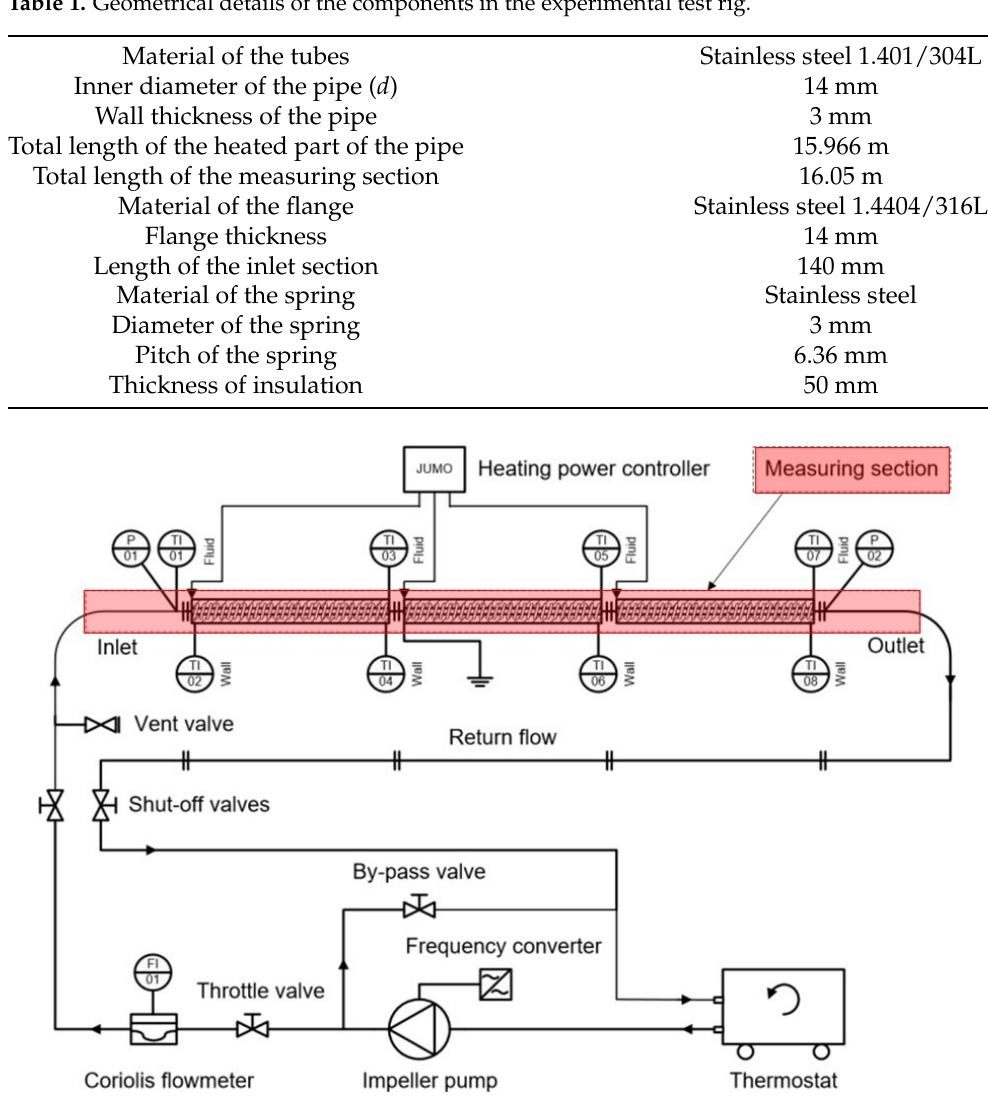
Figure 1. Schematic of the experimental test-rig used in this experimental investigation. The measuring section is highlighted. The figure was adapted from [18]. Table 2. Specifications and details of all types of sensors